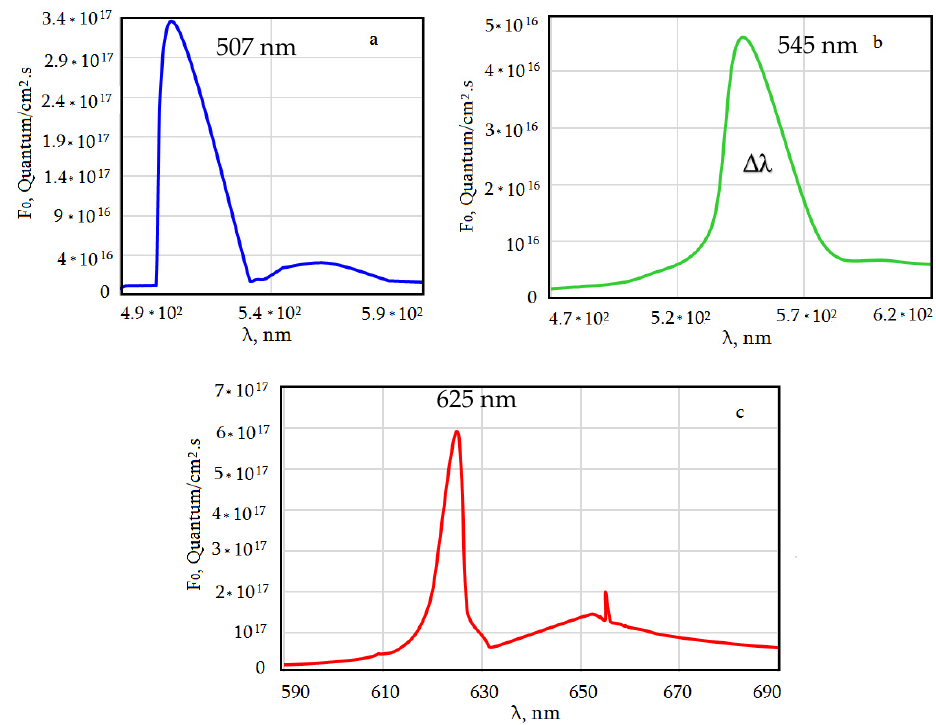
Figure 8. The spectral dependence of the intensity of the blue ( a ), green ( b ), and red ( c ), LEDs.